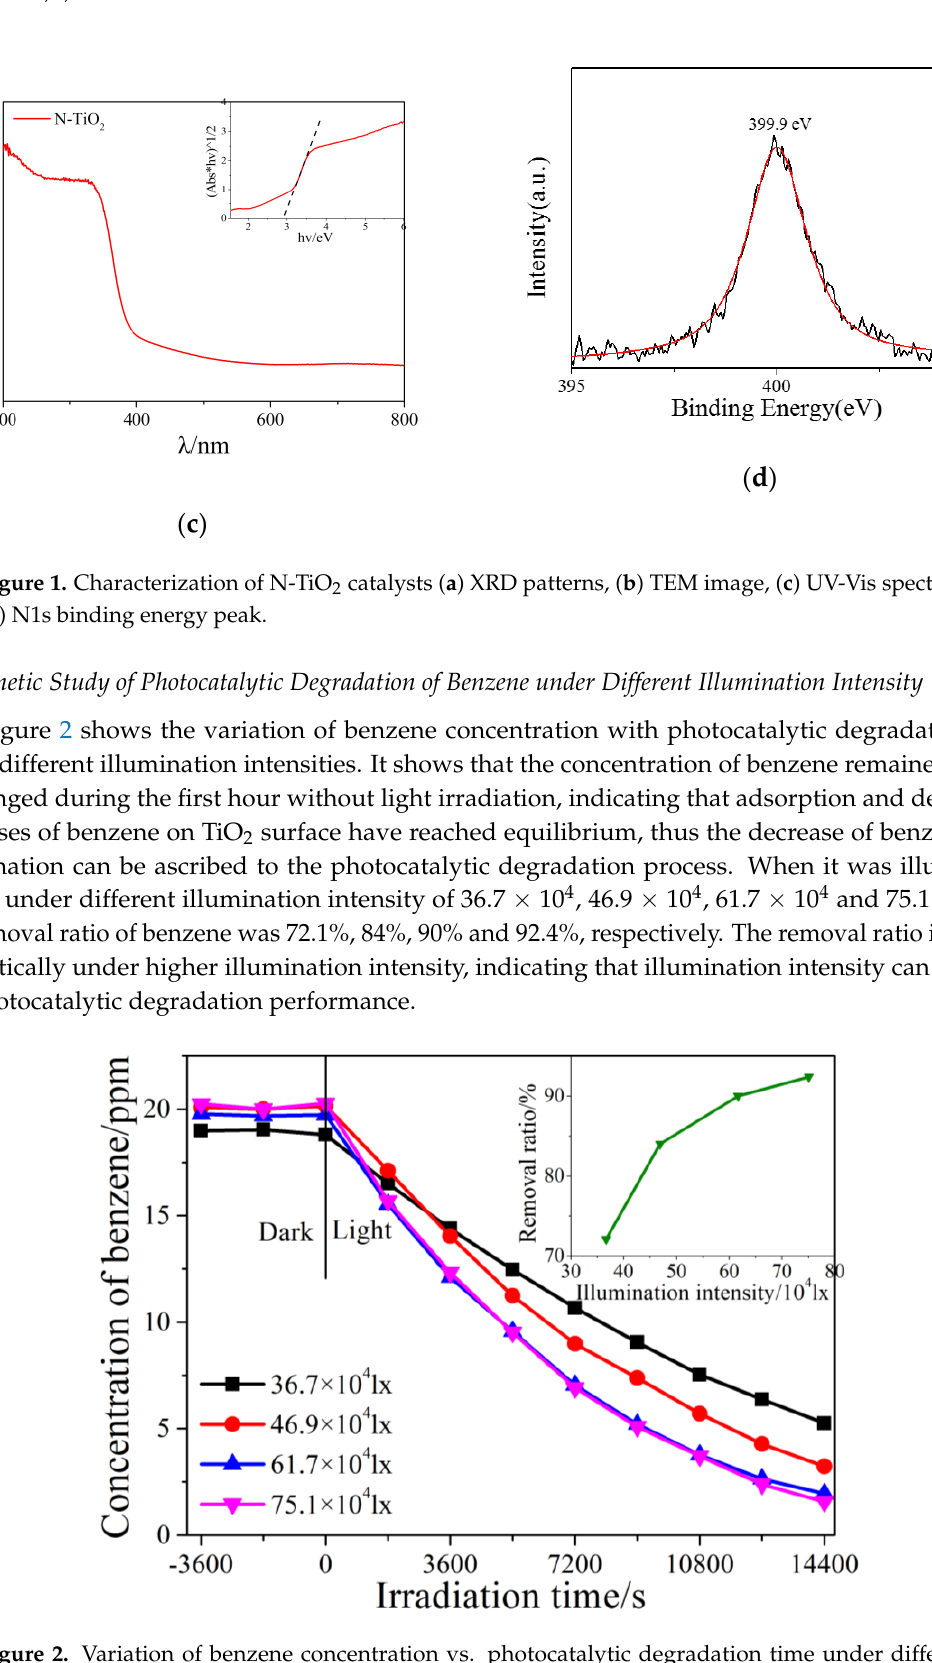
Figure 2. Variation of benzene concentration vs. photocatalytic degradation time under different illumination intensity.